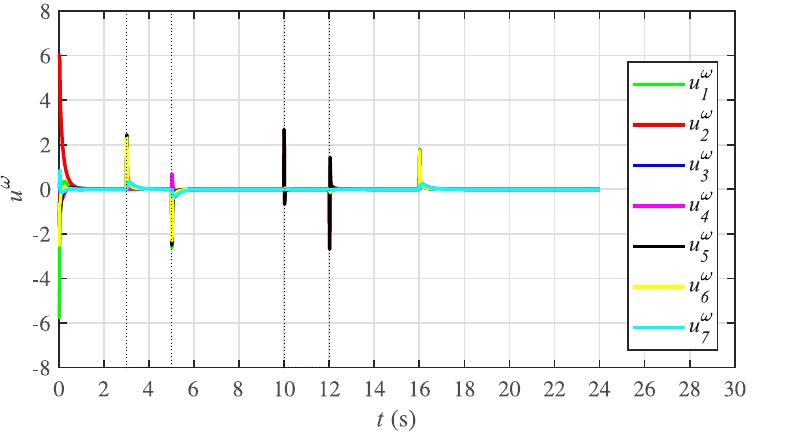
Fig 30. Frequency regulation control efforts under case 2.